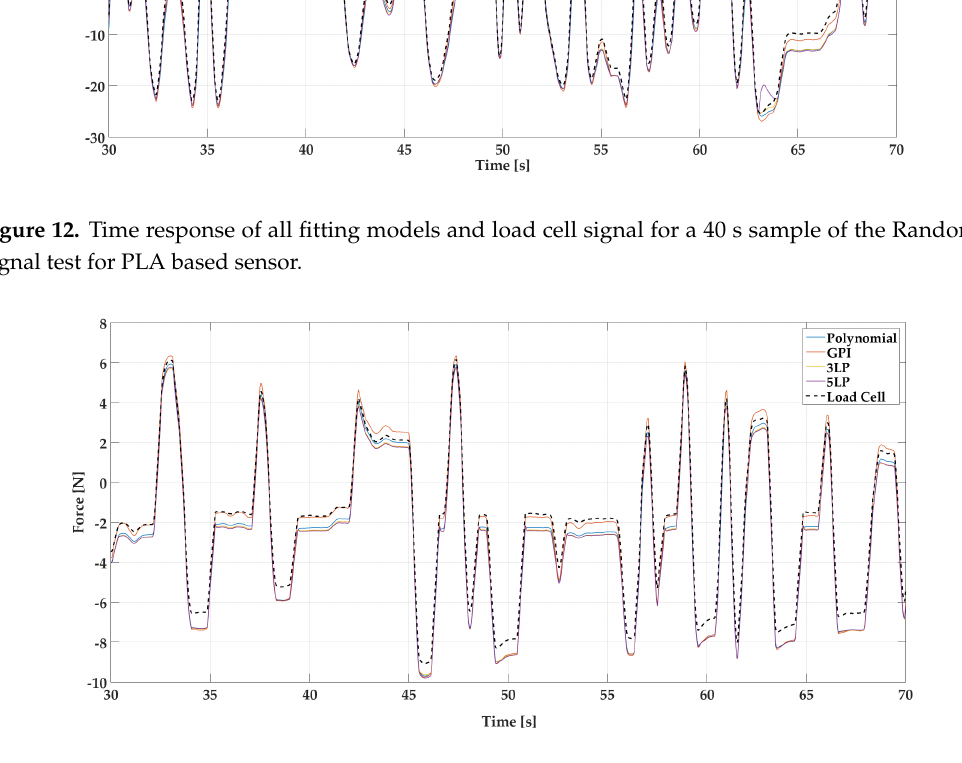
Figure 13. Time response of all fitting models and load cell signal for a 40 s sample of the Random Signal test for steel based